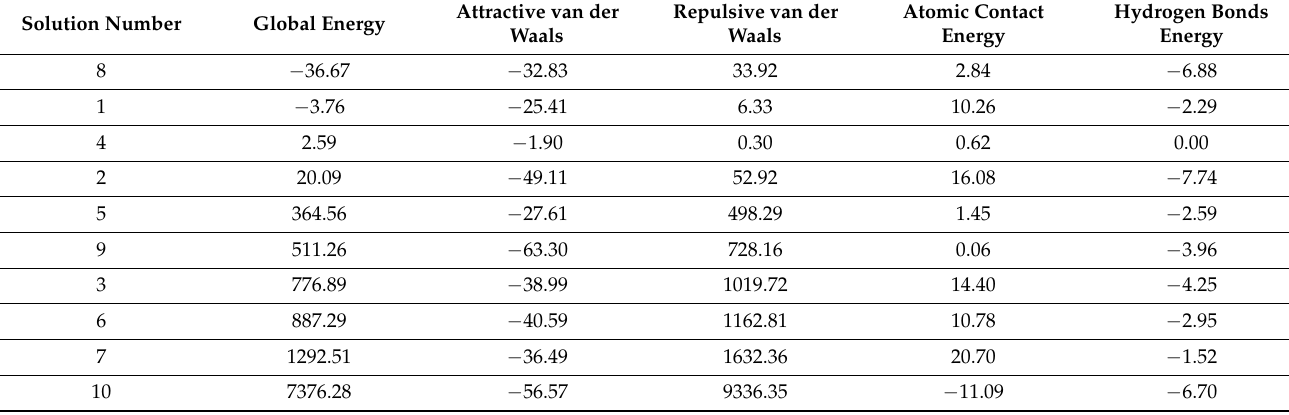
Table 13. Refined docked solution of the vaccine with TLR-4, generated by the FireDock